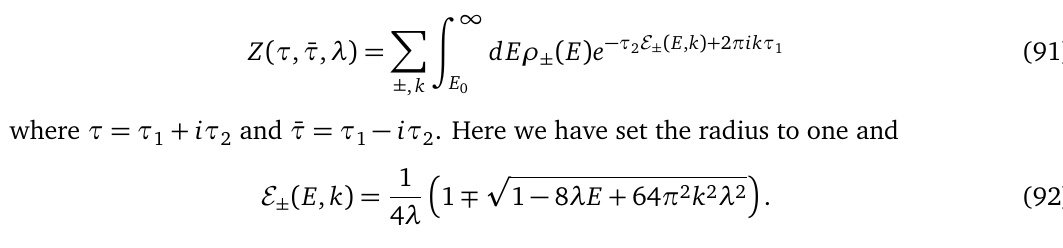
Figure 2: In orange, we show the undeformed density of states sinh ( 2 π gravity at infinite cutoff. In dashed black, we show the density of states of the theory with just the branch of the root, E − , that connects to the undeformed energies, until the energy complexifies. In blue, we show the density of states ρ λ ( E ) of the deformed partition function (89) which includes non-perturbative corrections in λ . Above we have set ˆ ρ ( E ) = 0 and λ = 1 / 4 and C = 1 / 2, the black line therefore ends at = 1. The vertical dashed line indicates the energy beyond which ˆ ρ has E = 1 4 λ